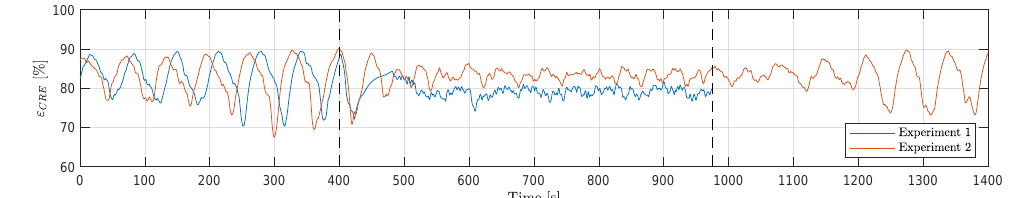
Figure 11. Concentration reduction efficiency during both experiments.